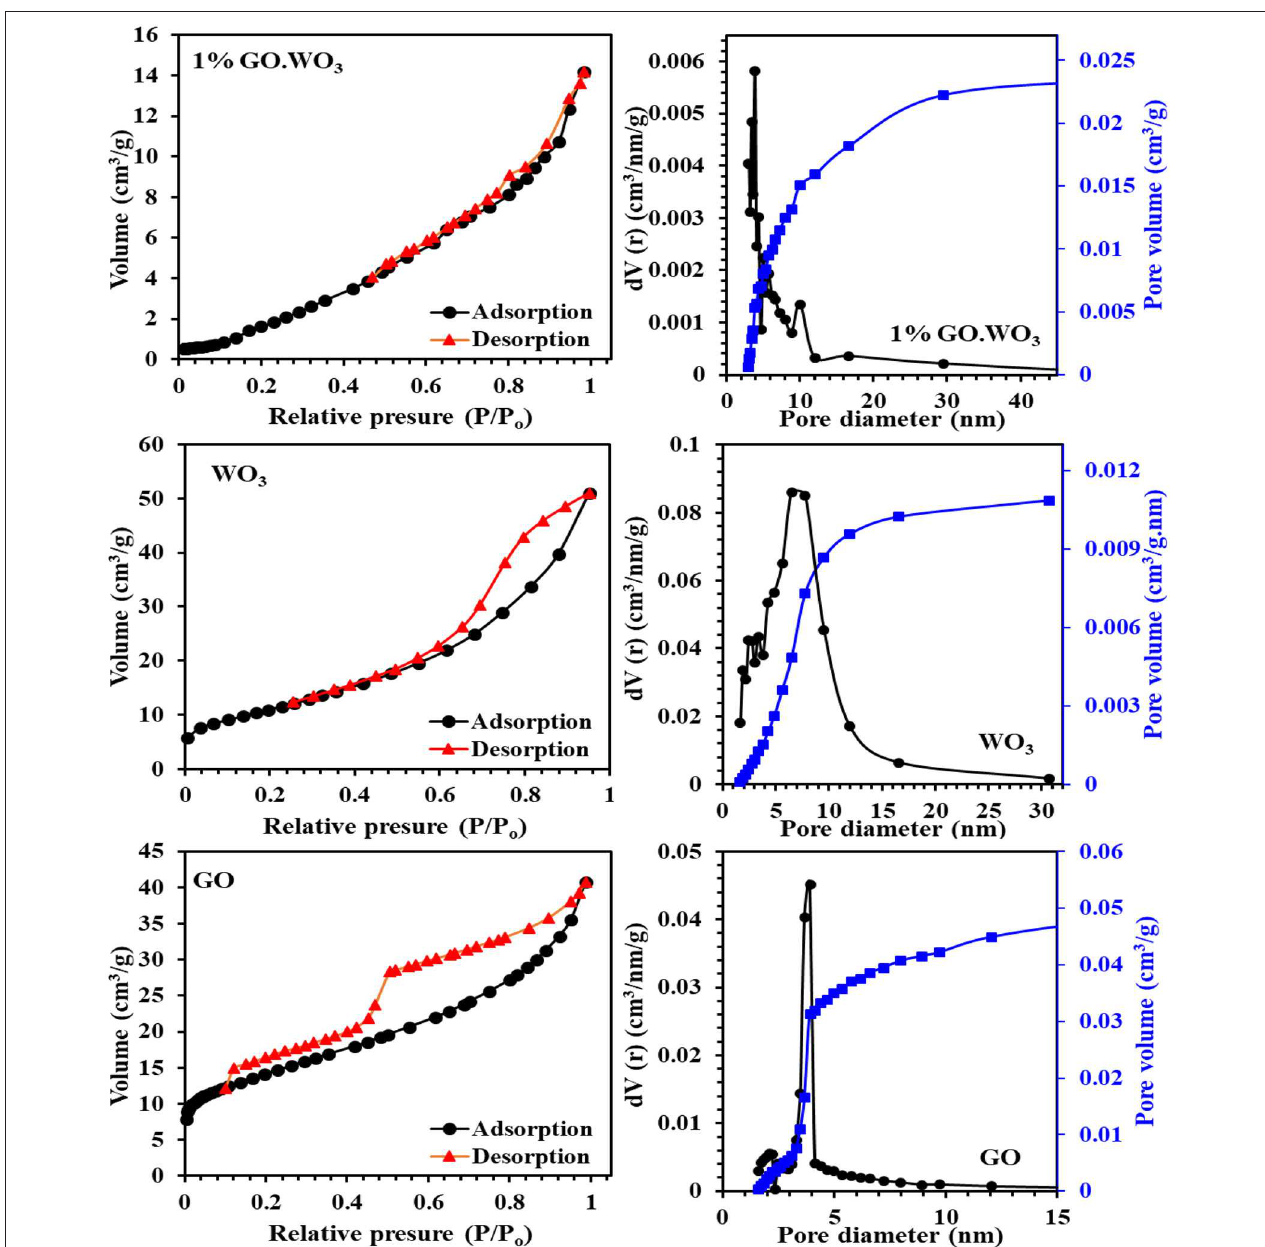
FIGURE 4 | Adsorption-desorption isotherms and pore size distribution curves (in-set) of GO, WO 3 , 1%GO.WO 3